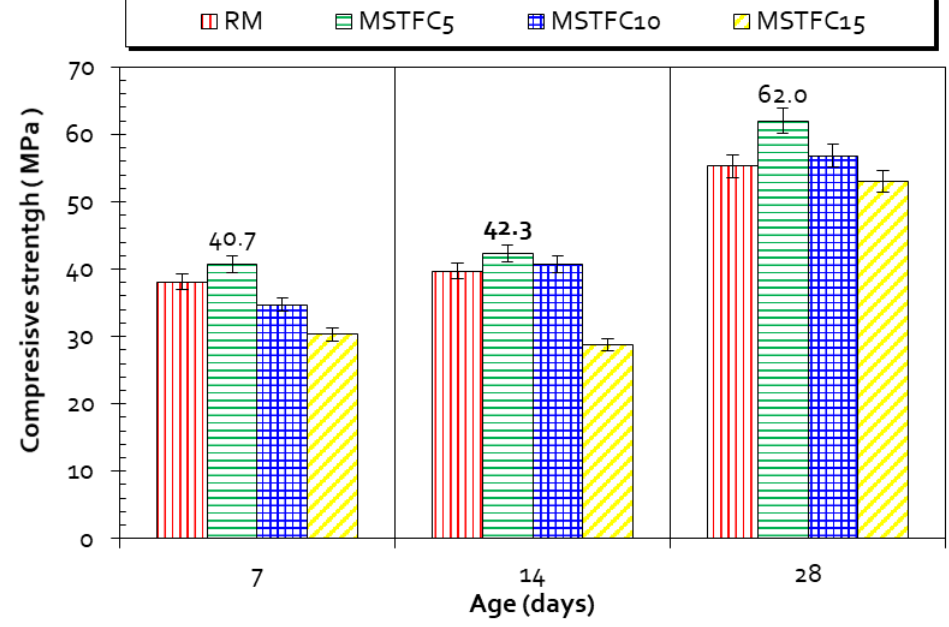
Figure 10. Compressive strength of RM and MSTFC (5%, 10%, and 15%) mortars.